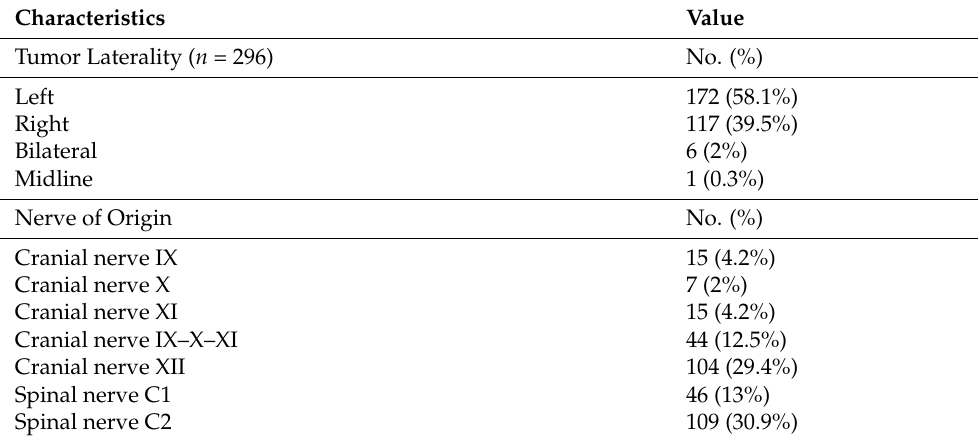
Table 2. Summary of tumor origin and radiological